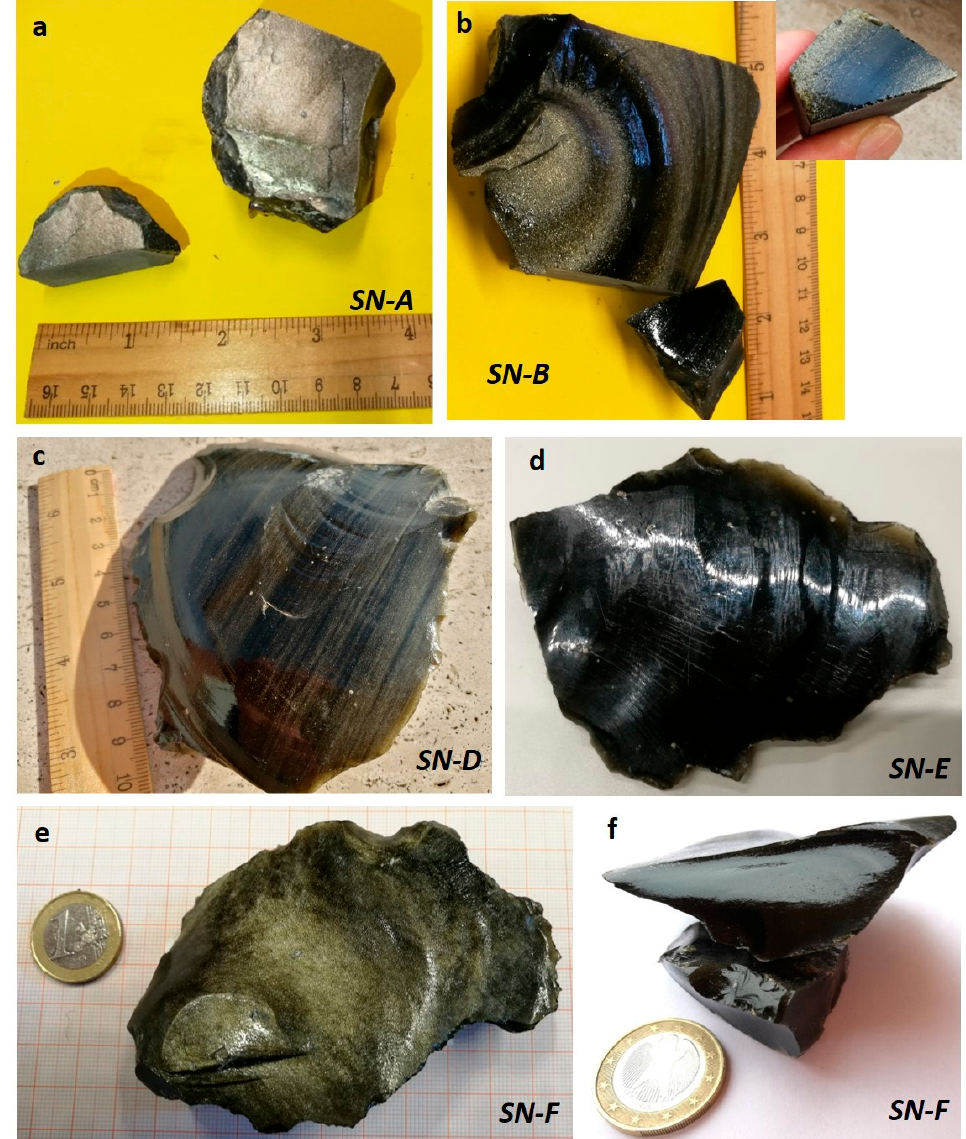
Figure 2. Macroscopic aspect of analyzed samples. ( a ) Sample SN-A. Note the flat surface, the green color, and the homogeneous, “metallic” hue. The microscopic observations and microanalyses were conducted on the upper surface of the smaller fragment. ( b ) Sample SN-B showing alternating dark and light bands with different roughness. In the inset, the small fragment used for microscopic observation and microanalysis. ( c ) Sample SN-D, smooth and with thin bands of different colors. ( d ) Sample SN-E. Note the absence of hue and the green color, visible only on the thinner edges. ( e ) Sample SN-F, homogeneously green with changing golden hue. Microscopic observations and microanalyses conducted on the upper surface. ( f ) Sample SN-F. Surface artificially hammered, roughly orthogonal to the surface shown in Figure 2e. Note the different, darker color.